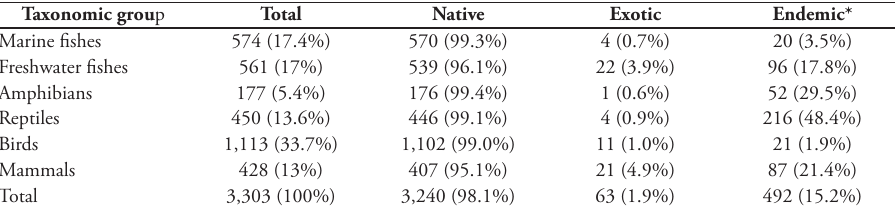
Table 2. Total number (and percentage) of species richness, native species, exotic species, and percentage endemism by taxonomic group. *The percentage of endemic species is calculated over the total of native species of the group.